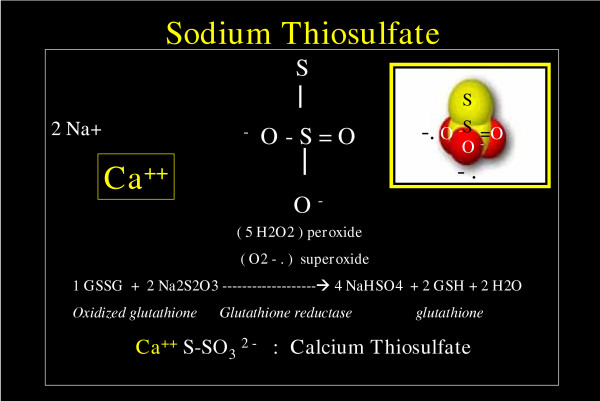
Sodium thiosulfate. This figure demonstrates the chemical structure of sodium thiosulfate, which is an antibrowning, reducing, and antioxidant agent: Capable of donating electrons to re-pair unpaired damaging electrons to be an effective antioxidant as well as a chelator of cations such as the calcium excess in calcific uremic arteriolopathy – CPLX.